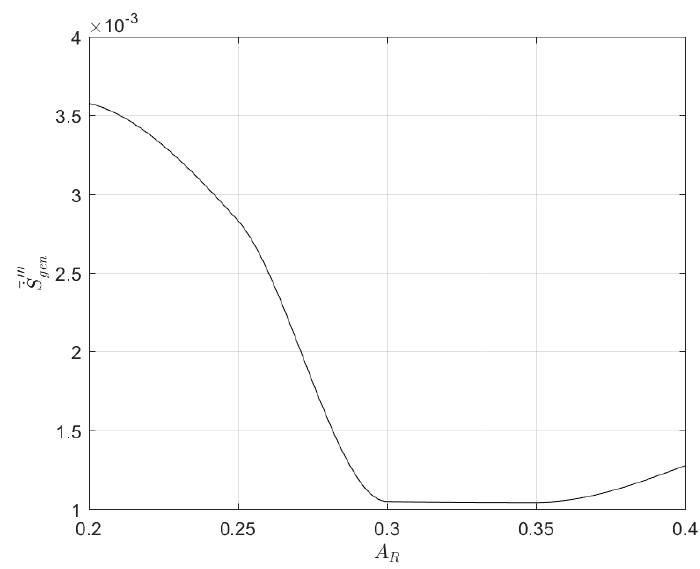
Figure 4. Generated entropy vs. the aspect ratio for N r = 10.